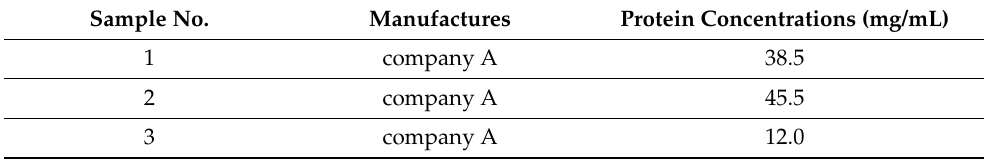
Table 1. Protein concentrations of tested soymilks. Sample